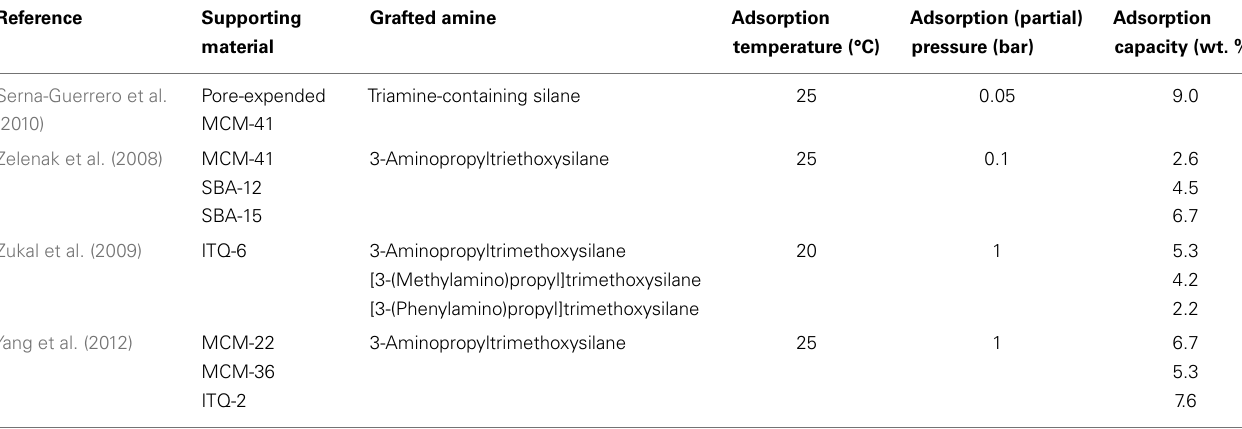
Table 3 | Key parameters for Class 2 immobilized amine adsorbents .